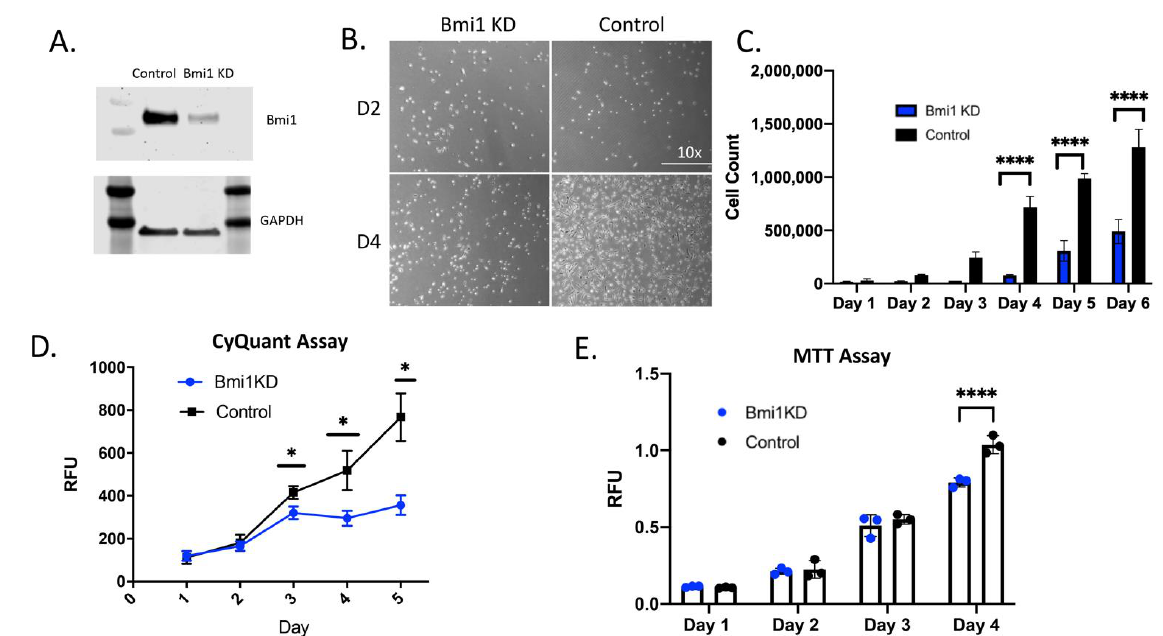
Figure 2. Bmi1 knockdown inhibits proliferation of CBSCs: ( A ) Western blot representative image of the control and the Bmi1 knockdown relative to GAPDH; ( B ) representative images of Bmi1 knockdown using shBmi1 lentivirus and the control using shScramble in CBSCs grown over 4 days; ( C ) cell count of the Bmi1 knockdown and control over 5 days ( p value for Day 4 p < 0.0001 Day 5 p < 0.0001, n = 3); ( C , D ) Graph of the CyQuant assay comparing Bmi1 knockdown and control CBSC DNA content ( p value for Day 3 0.0002, Day 4 < 0.0001, and Day 5 < 0.0001, n = 3); and ( E ) graph of MTT assay comparing Bmi1 knockdown to control CBSCs ( p value for Day 4 < 0.0001, n = 3). * p < 0.05, **** p < 0.0001.